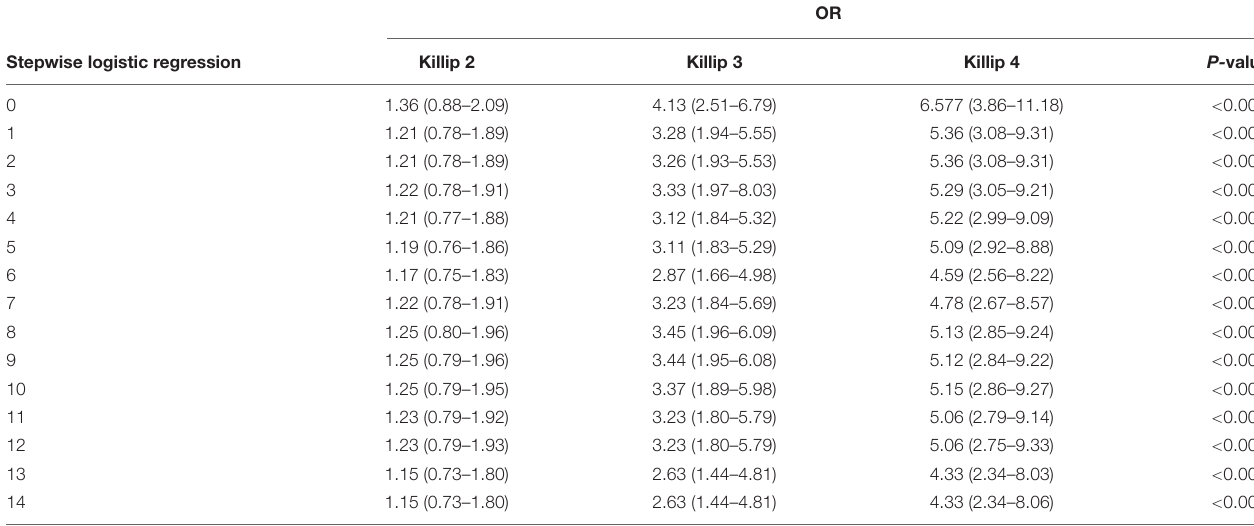
TABLE 3 | The adjusted relationship between Killip classification and